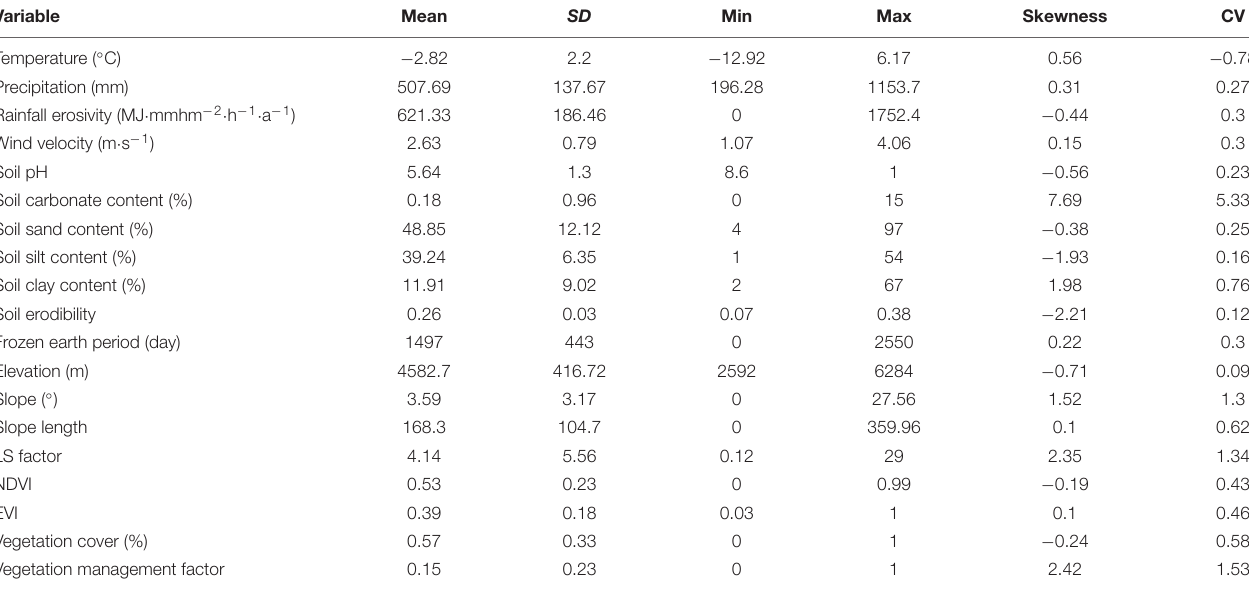
TABLE 1 | Descriptive statistics of the continuous variables characterizing soil and environmental properties among the 165 sampling